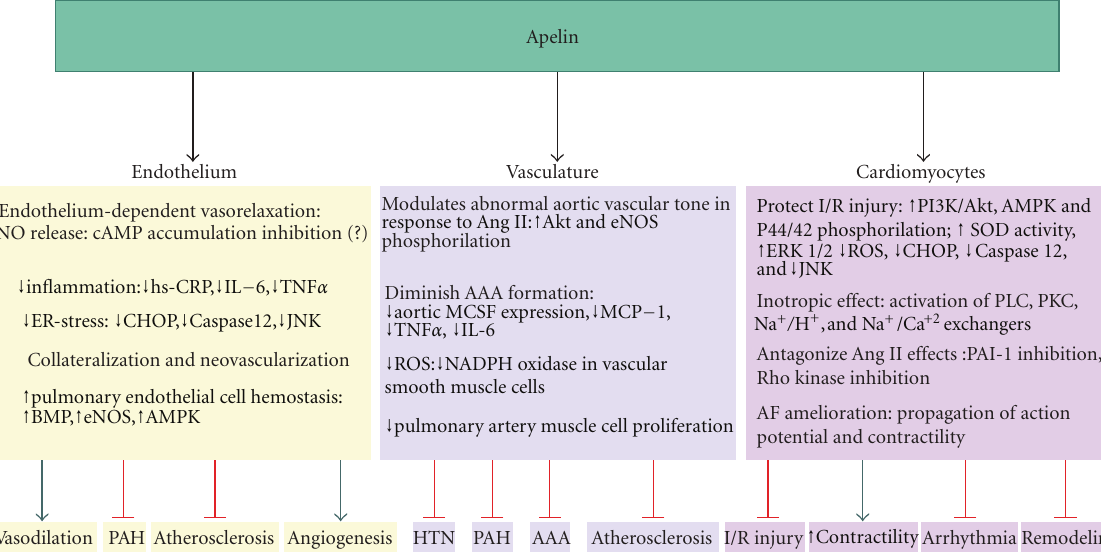
Figure 2: Diverse e ff ects of apelin on cardiovascular system. Black arrows, e ff ects of apelin on various targets; Green arrows and red bars, favorable stimulatory and inhibitory e ff ects of apelin on cardiovascular system respectively; AAA: abdominal aorta aneurysm; AF: atrial fibrillation; Akt: protein kinase B; AMPK: adenosine monophosphate-activated protein kinase; BMP: bone morphogenetic protein; CHOP: CCAAT/enhancer binding protein homologous protein; eNOS: endothelial synthase; hs-CRP: high sensitivity C-reactive protein;